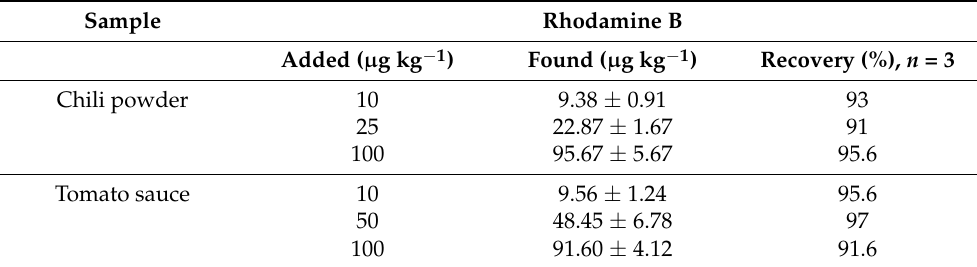
Table 5. Determination results and recovery study of Rhodamine B in food samples by the proposed